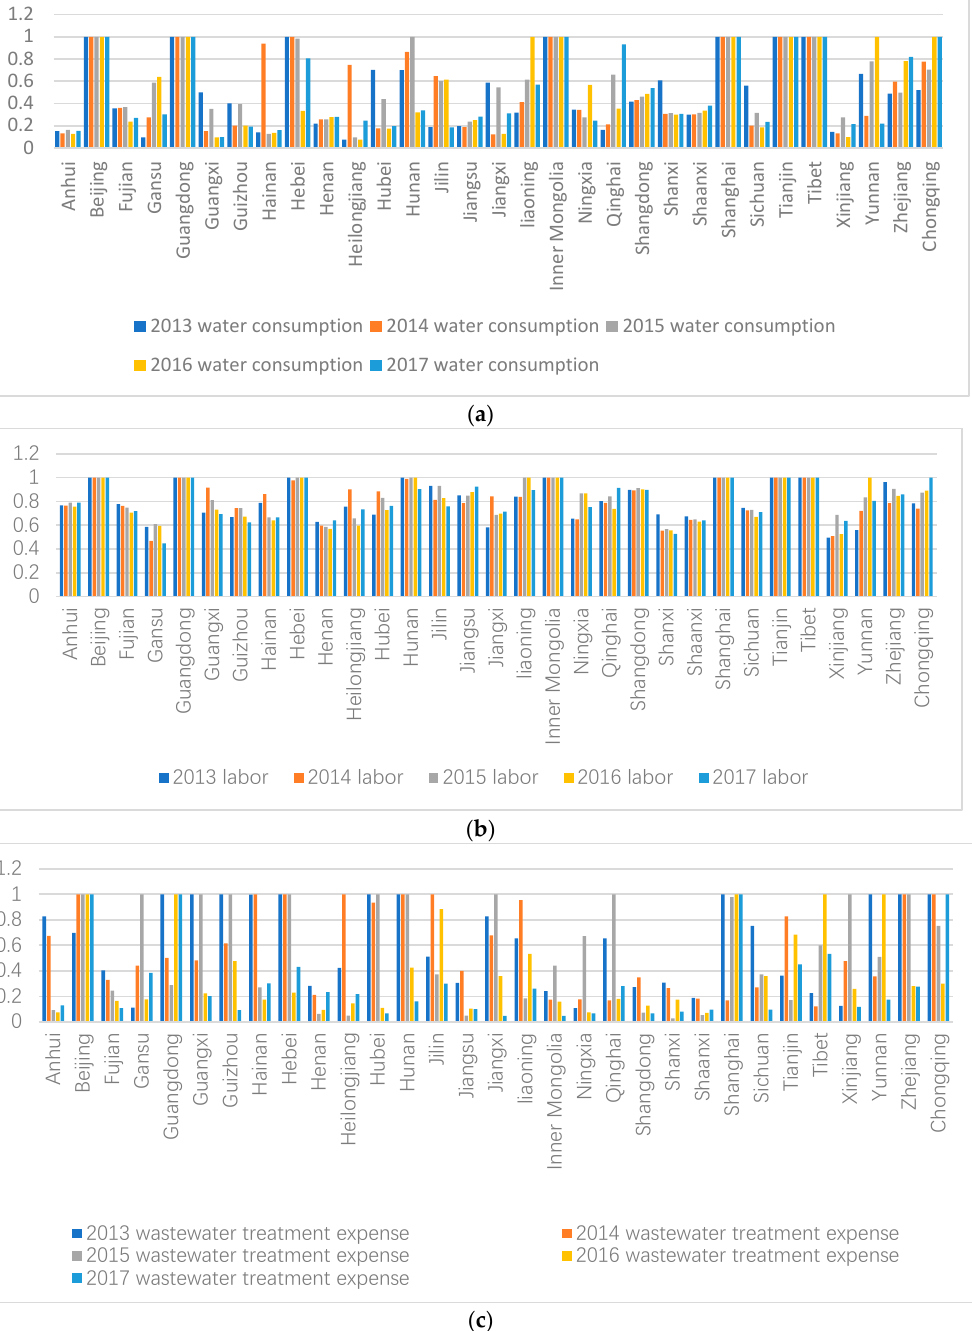
Figure 3. ( a ) Water consumption efficiency in provinces, municipalities, and autonomous regions from 2013 to 2017. ( b ) Labor efficiency of provinces, municipalities, and autonomous regions from 2013 to 2017. ( c ) Wastewater treatment cost and efficiency in provinces, municipalities, and autonomous regions from 2013 to 2017.